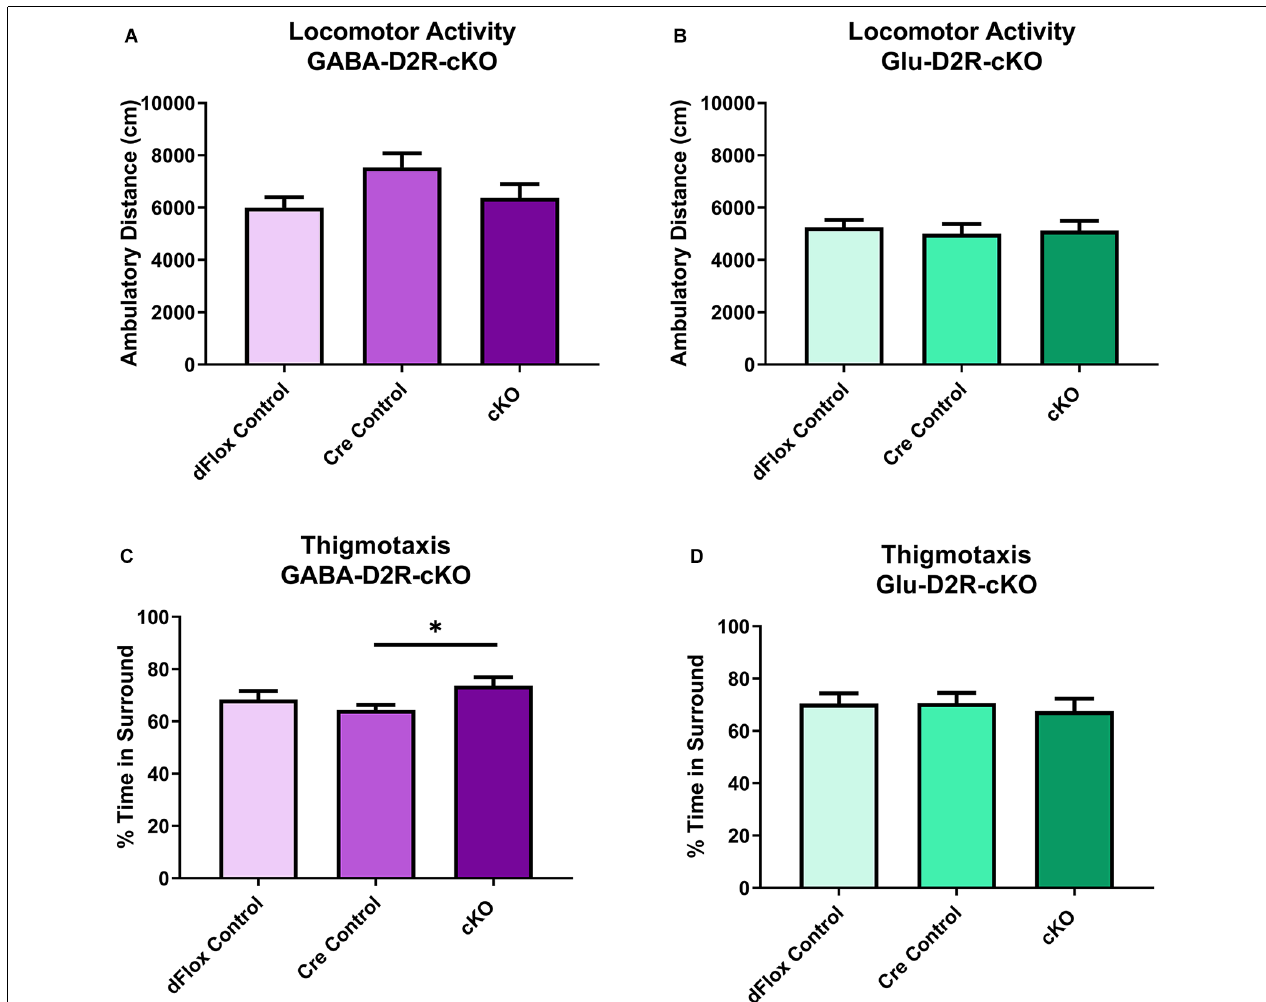
FIGURE 3 | No changes in basal locomotor activity in GABA-D2R-cKO and Glu-D2R-cKO mice. No changes in basal activity levels were apparent in the GABA-D2R-cKO (A) or Glu-D2R-cKO (B,D) lines, respectively. Post hoc analysis did reveal that GABA-D2R-cKO mice did spend more time in the sides and corners of the chamber than the corresponding Cre controls (C) . N = 10–13/group; ∗ p <